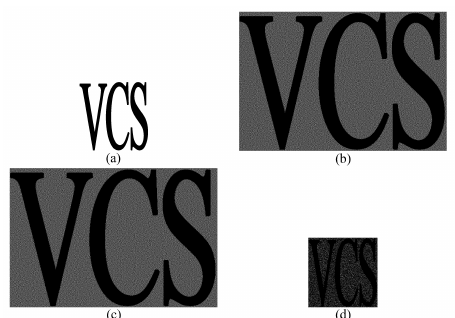
Figure 8. The experimental results of Arumugam et al.’s (1, 1, 3, 4)-VCS, Guo et al.’s (1, 1, 3, 4)-VCS and the proposed (1, 1, 3, 4)-EVCS. ( a ) the secret image; and, ( b – d ) the revealed image of the three schemes, respectively. Table 9. The comparison of functionality among the literature schemes and proposed EVCS.